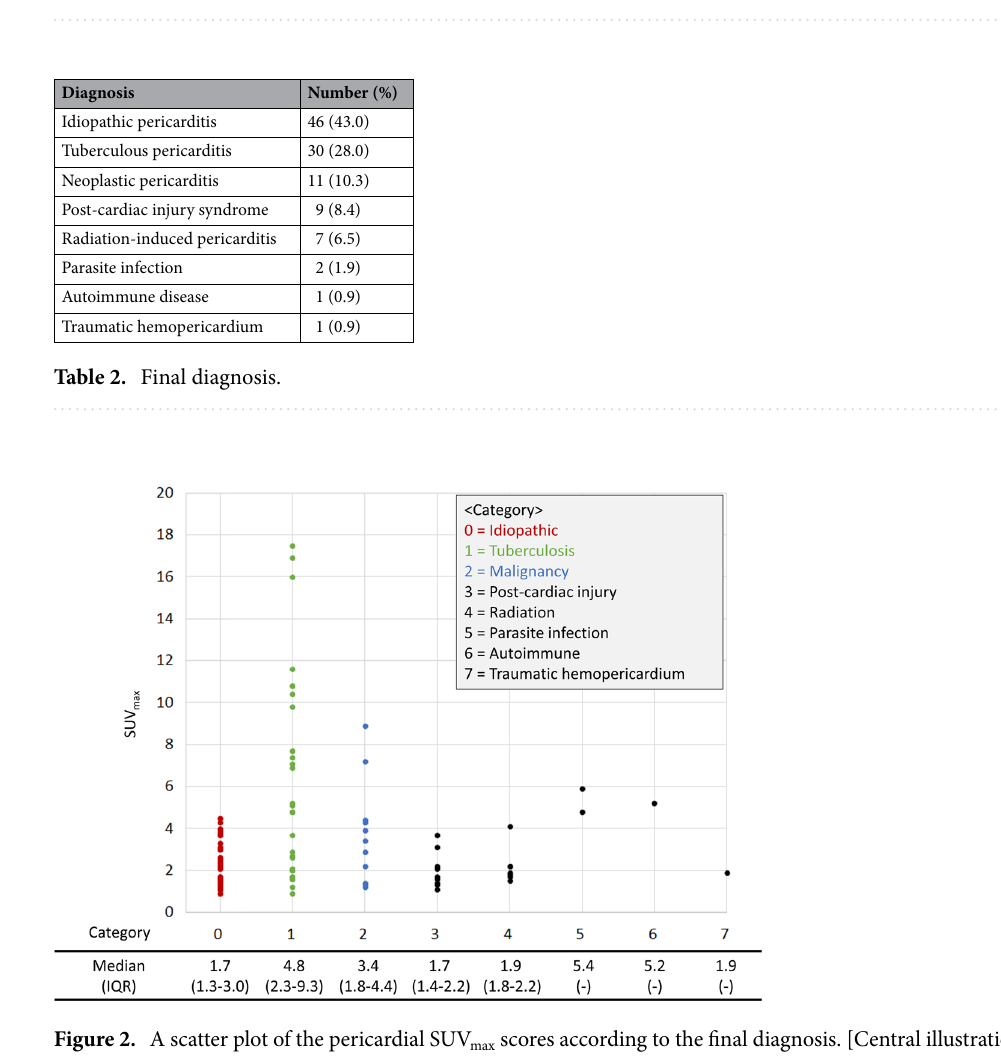
Table 1. General characteristic and past medical history. Data are presented as number (%) or mean (± standard deviation).